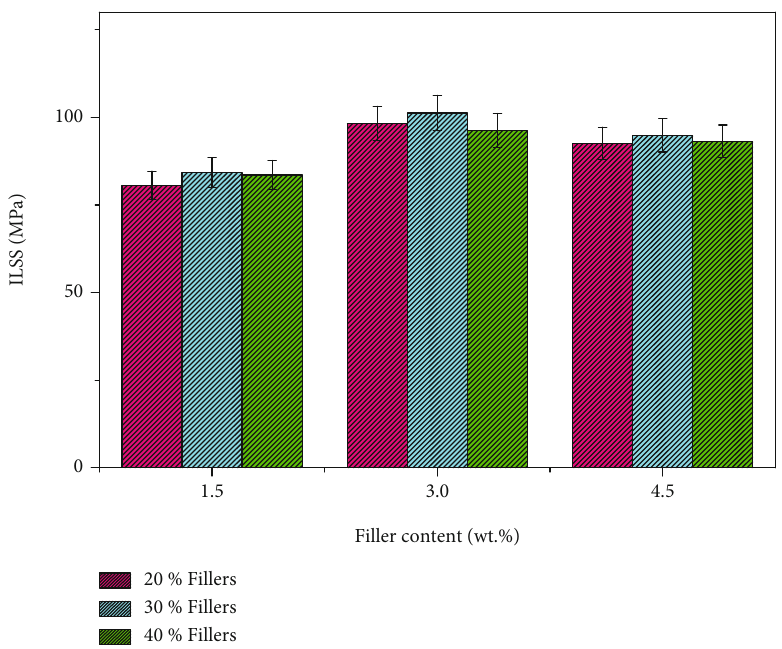
Figure 8: ILSS of nanocomposites with di ff erent fi ller and fi bre content.